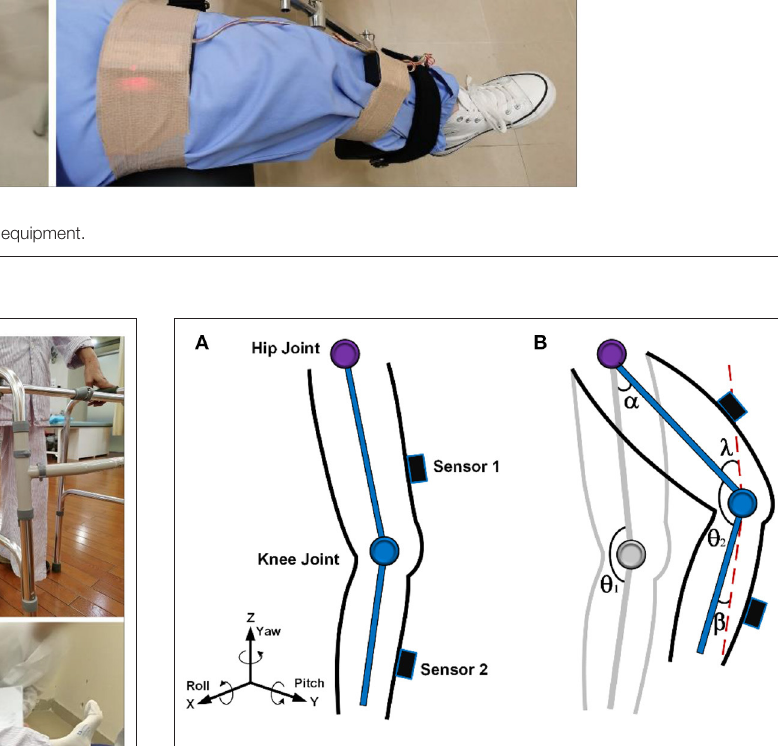
FIGURE 4 | Sensor attitude angle and knee ROM estimation. (A) Three-axis acceleration and gyroscope direction. (B) Equivalent model of flexion-extension